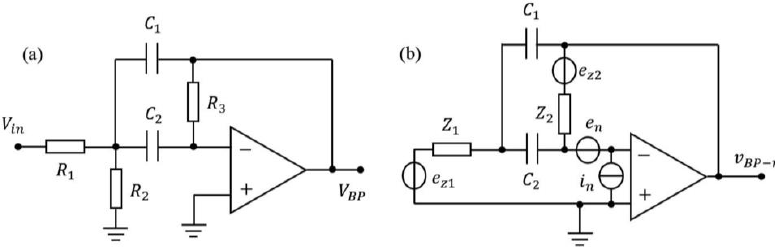
Figure 5. Noise analysis of the band-pass filter. ( a ) Schematic diagram of the band-pass filter. 𝑉 𝑖𝑛 and 𝑉 𝐵𝑃 are the input and output voltage of band-pass filter, respectively. ( b ) Noise model of the band-pass filter. The input of band-pass filter is grounded. 𝑍 1 = 𝑅 1 //𝑅 2 and 𝑍 2 = 𝑅 3 . filter. The input of band-pass filter is grounded. Z 1 = R 1 // R 2 and Z 2 = R 3